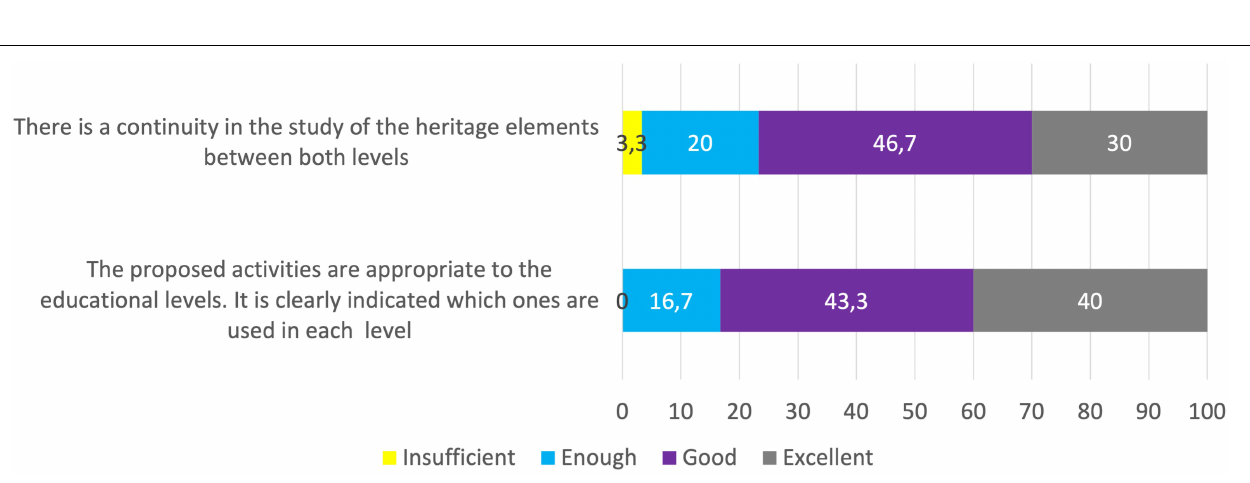
GRAPH 2 | Students’ perception of skills acquired in selected questions of the initial and final questionnaire. Percentages. ∗ Statistically meaningful relationship: chi-square = 61.992, df = 3, p = 0.000. ∗∗ Only asked in the final survey.